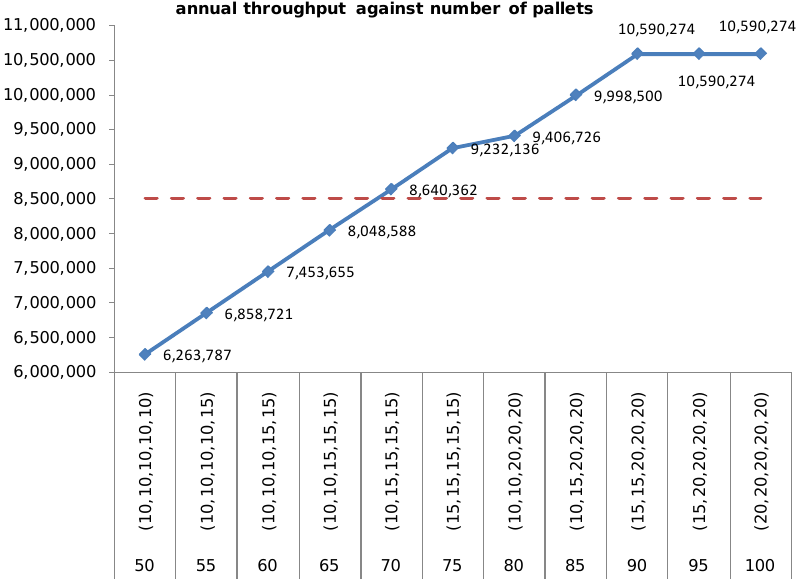
Figure 10. “Throughput against possible pallet combination”. Source: